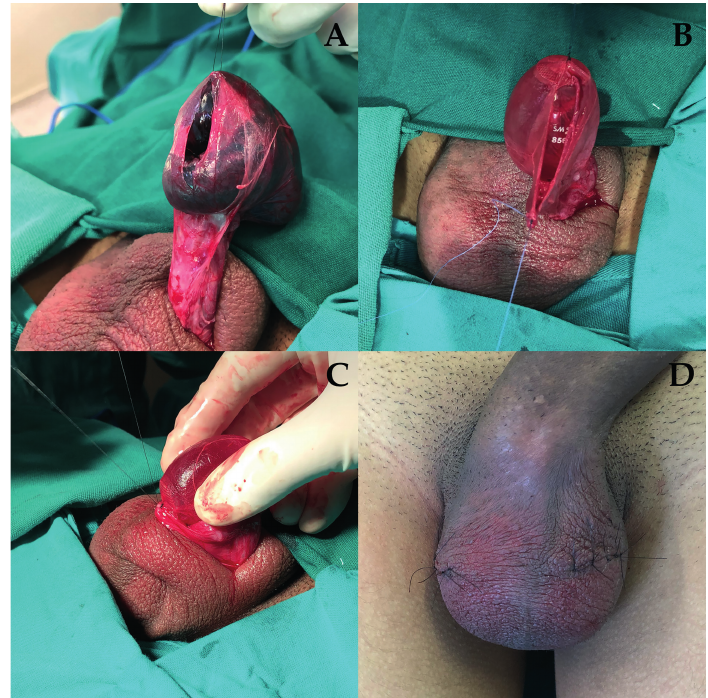
Figure 1 - Immediate prosthesis implantation in a 16 years-old boy using the proposed surgical technique. A) TV mobilization and posterior incision to the tunica vaginalis cavity, B) Prosthesis placed and sutured to the most pendent part of the TV cavity, C) Prosthesis anchored at the most pendent part of the scrotum to the dartos tunica, D) Immediate post-operative in the